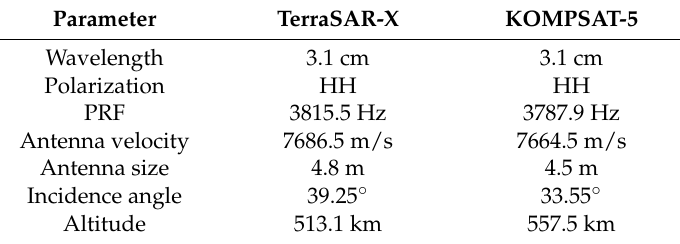
Table 2. SAR system parameters used in this